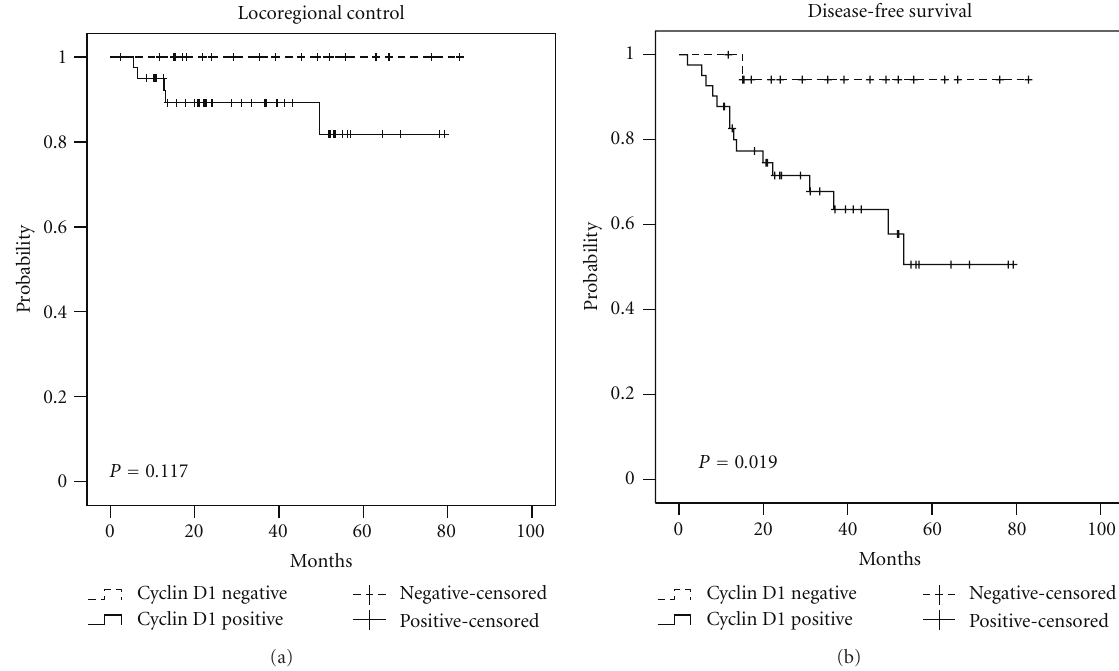
Figure 3: Locoregional control and disease-free survival stratified by cyclin D1 status.